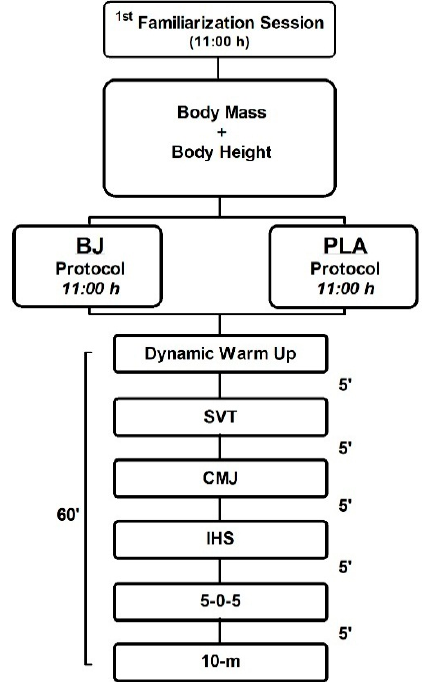
Figure 1. Experimental design flow chart. Abbreviations: BJ: beetroot juice; PLA: placebo; SVT: Serve velocity test; CMJ: counter movement jump; IHS: isometric handgrip strength; 5-0-5: Agility Test: 5-0-5; 10-m: 10 m sprint.